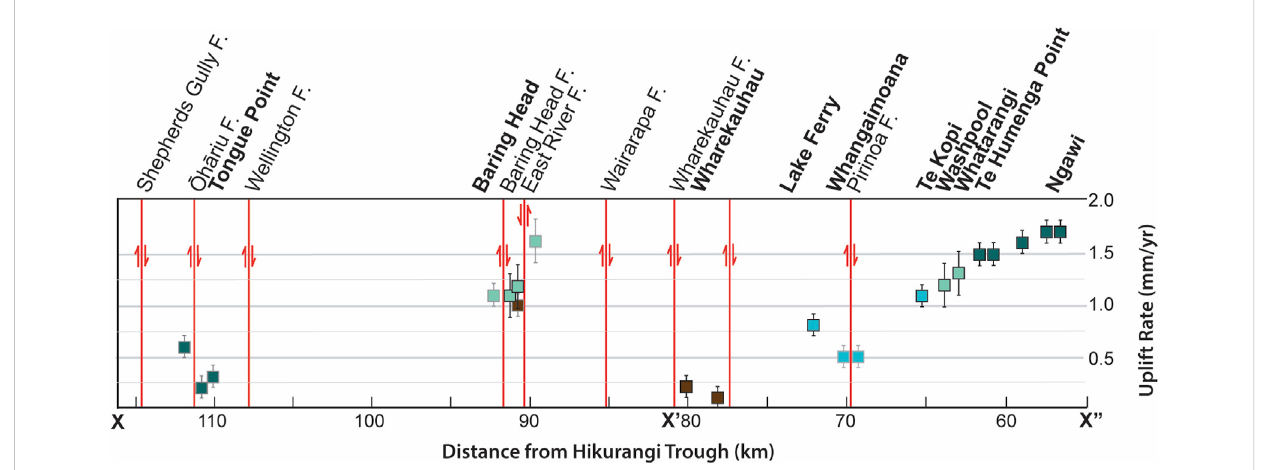
FIGURE 6 Uplift rates and associated uncertainties calculated from the shore platforms preserved along the Wellington south coast; black outline – rates determined from shoreline angle reconstructions; grey outline – minimum uplift rates calculated from shore platfrom spot elevations, where shoreline angle elevations could not be determined. The different colours denote the different aged marine terraces (coloured as in Figure